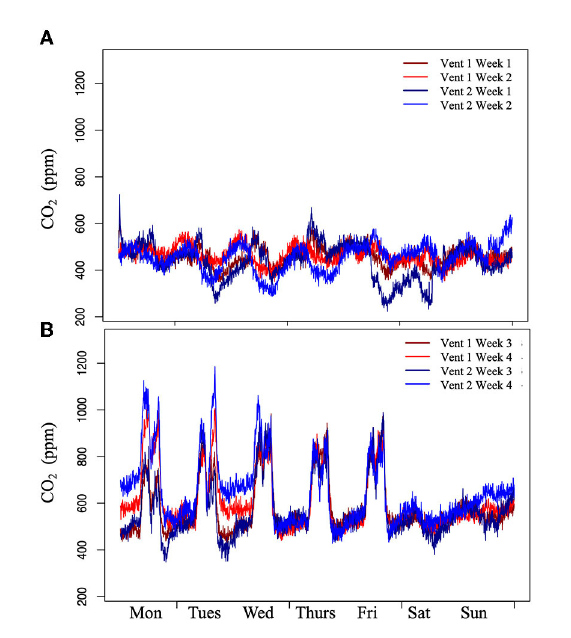
FIGURE4 CO 2 released from rooftop vents on a building while unoccupied and occupied over 4 weeks. Sensors were attached to two vents on The BUA roof for 4 weeks. (A) During the first 2 weeks, only baseline staff were present and (B) during the second 2 weeks a camp was being run. There were no CO 2 peaks in the first 2 weeks and peaks up to 1,300 ppm during the second 2 weeks indicating the connection between Exhaust Vent CO 2 and building